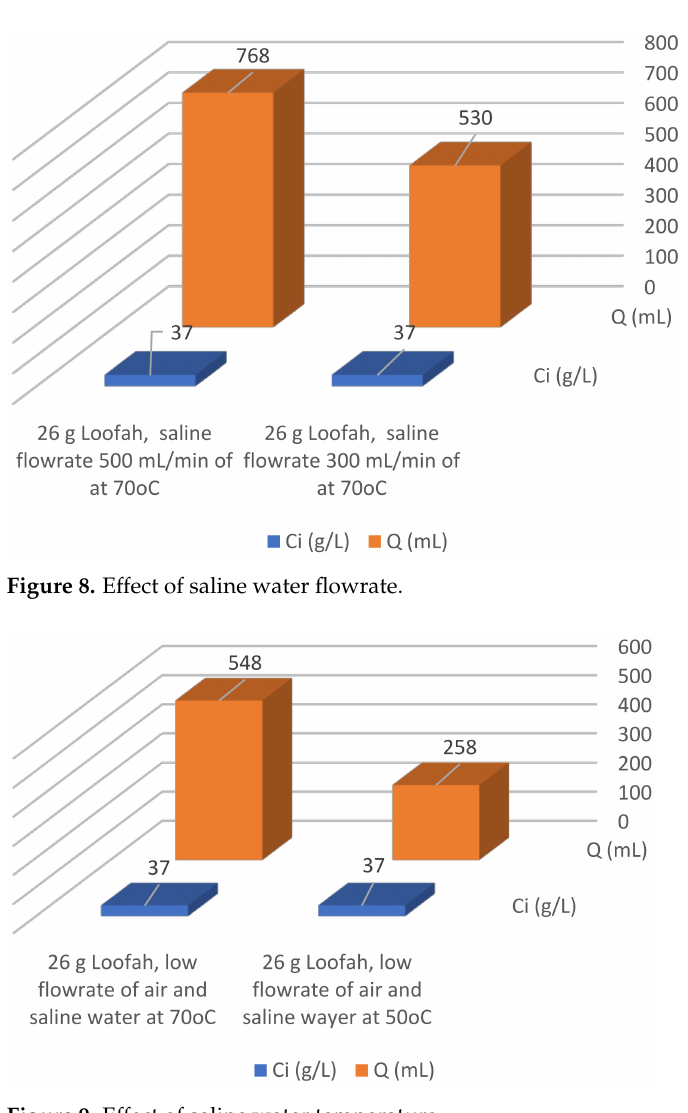
Figure 9. Effect of saline water